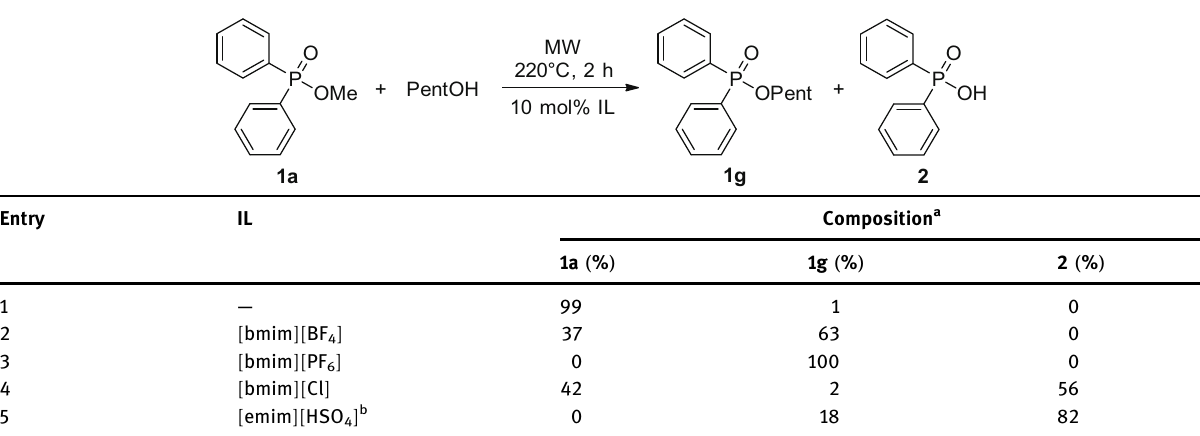
Table 5: Alcoholysis of methyl diphenylphosphinate ( 1a ) with pentanol under MW conditions in the presence of di ff erent